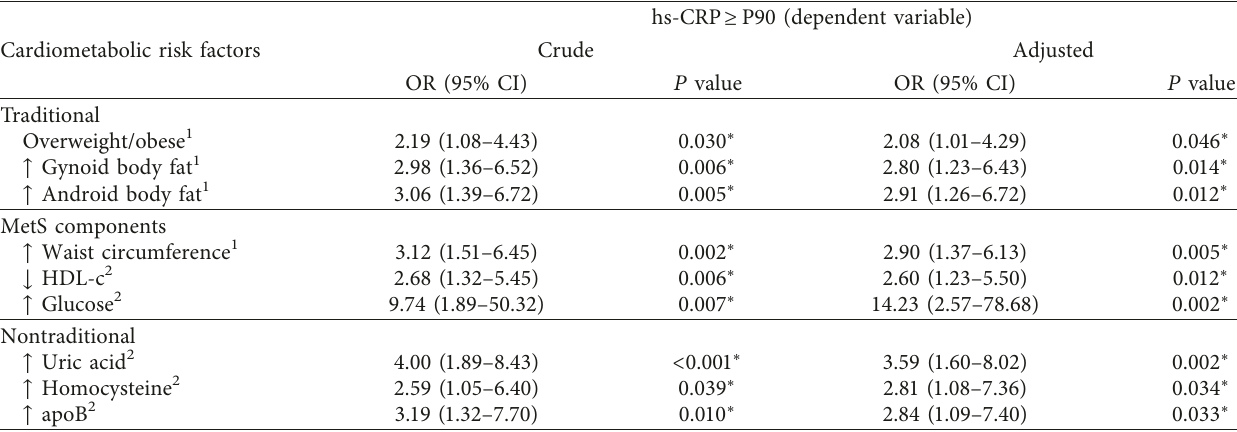
Table 4: Crude and adjusted odds ratio (OR) of the association between serum hs-CRP concentrations and cardiometabolic risk factors in children, Viçosa, MG, Brazil, 2015.